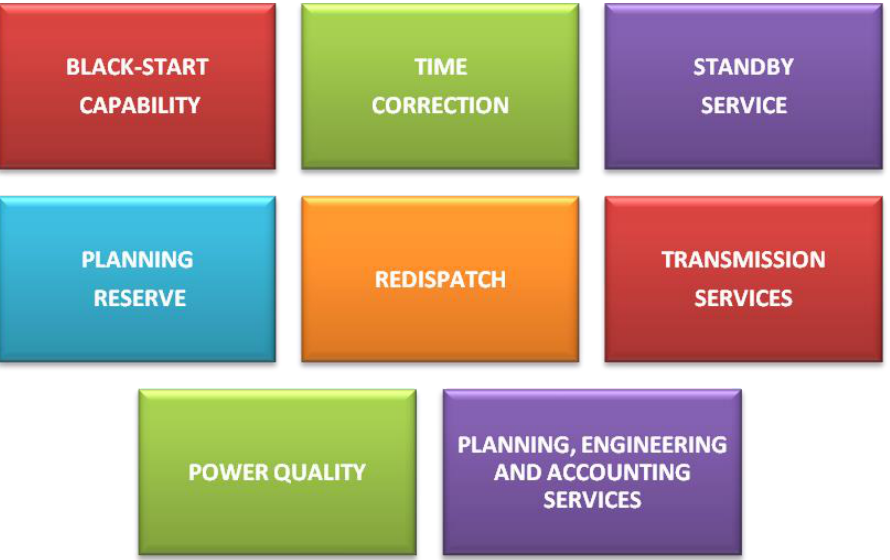
Figure 3. Additional services in electric power market suggested by FERC.